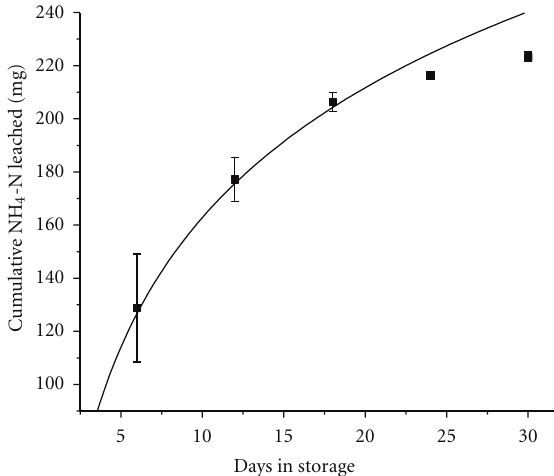
Figure 7: Cumulative NH 4 -N (mg NH 4 -N per manure storage unit) leached from manure of the rainy season storage experiment. Error bars represent standard error of the mean values. The continuous line represents best-fit regression equations for cumu- lative NH 4 -N (mg) leached from manure during the dry season experiment. X represents the number of days in storage. The solid line represents all treatments. Y represents the cumulative NH 4 -N (mg) leached from the manure. All treatments: Y = 70 . 7127ln( x ), R 2 = 0 . 998. 199 mg NH 4 -N while storage units containing only manure lost an average of 104 mg NH 4 -N over 120 days of